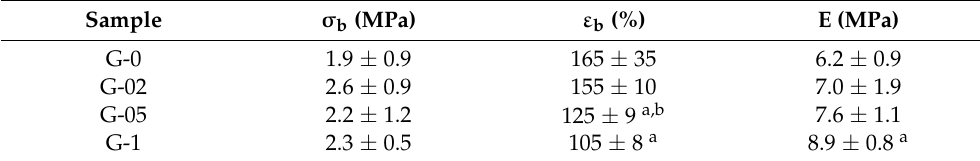
Figure 9. Typical stress–strain curves of ( a ) G films and ( b ) GTA films at different curcumin content. Table 3. Strain at break, σ b , stress at break, ε b , and Young’s modulus, E, of gelatin films. Each value is the mean of at least seven determinations and is reported with its standard deviation.